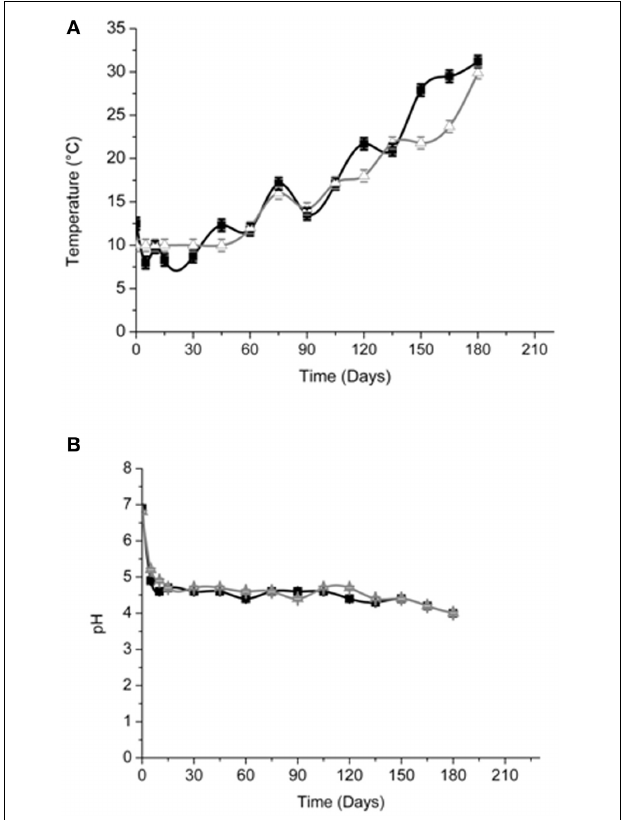
FIGURE 2 | Temperature (A) and pH (B) of Cellina di Nardò and